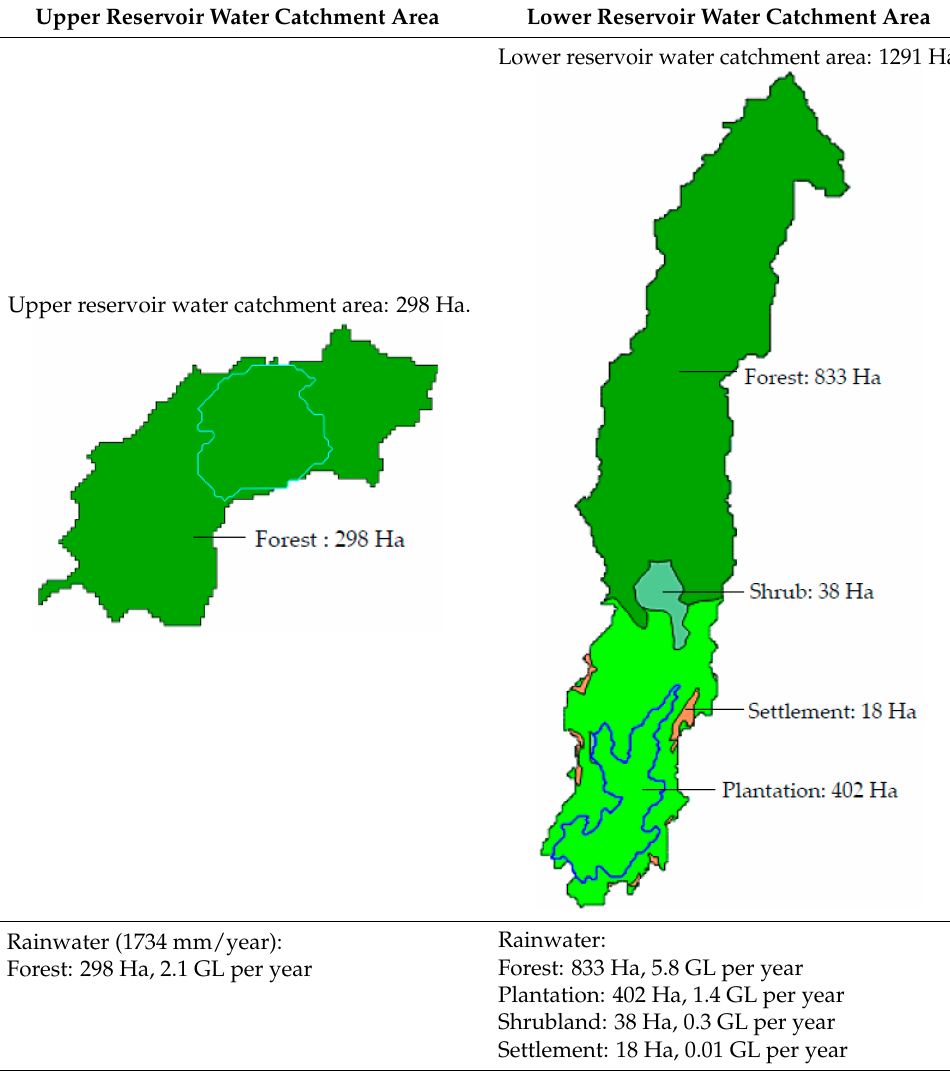
Table 5. Land categorisation and rainwater estimation in the water catchment area for an example PHES system in Jembrana Regency, Bali. The actual reservoir area is outlined in blue in each image. Upper Reservoir Water Catchment Area